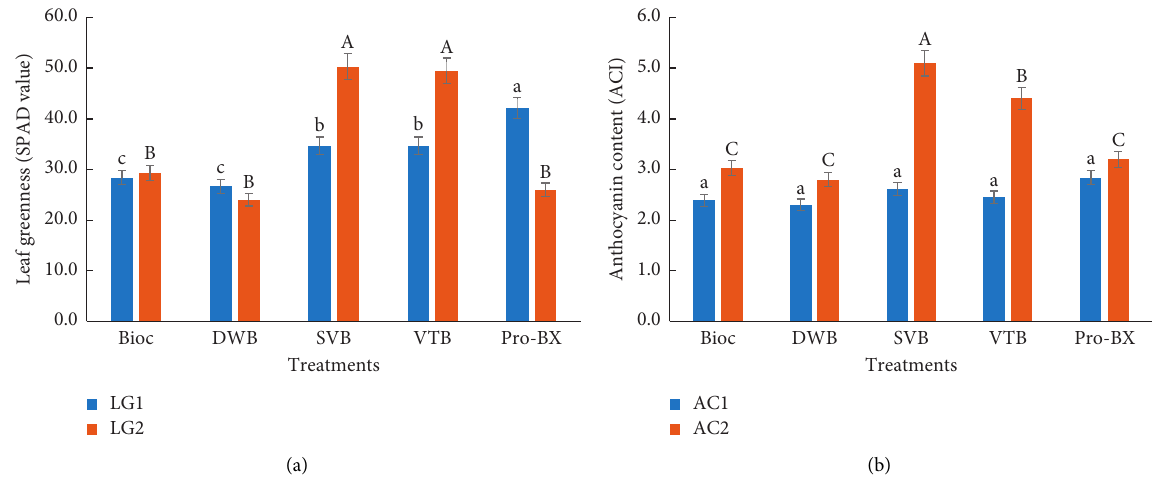
Figure 3: Leaf greenness and anthocyanin content of Swiss chard ( Beta vulgaris subsp. vulgaris) cv. Rhubarb chard as affected by biochar alone (Bioc), deionized water-inoculated biochar (DWB), solid vermicast-inoculated biochar (SVB), vermicast tea-inoculated biochar (VTB), and Promix-BX alone (Pro-BX). Lowercase and uppercase alphabetical letters represent mean separation by the least significant difference ( α � 0.05) at the first (1) and the second (2) harvests, respectively. Vertical lines on bars represent standard error of the